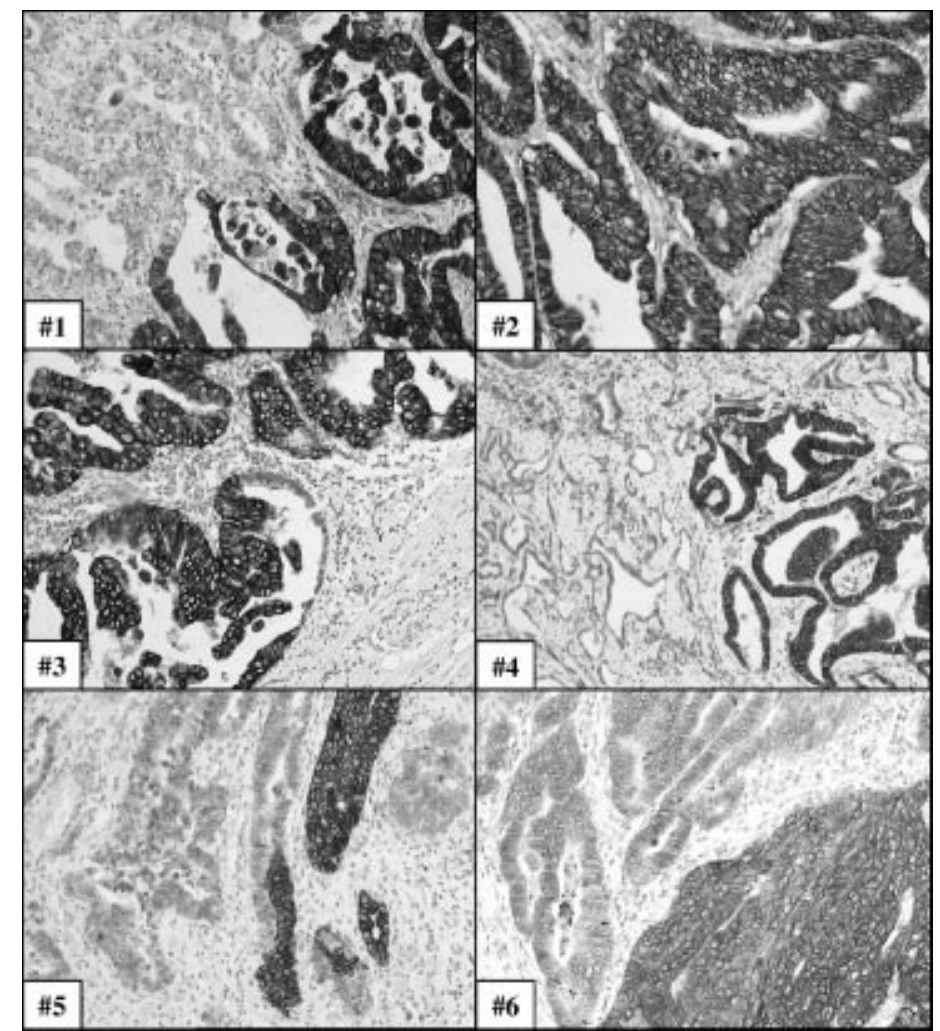
Fig. 2. Heterogeneous pattern of c-erbB-2 immunostaining in six BCA. #1, #3, #4, #5, #6 note the marked intratumoural heterogeneity of c-erbB-2 overexpression; #2, virtually every cell is strongly